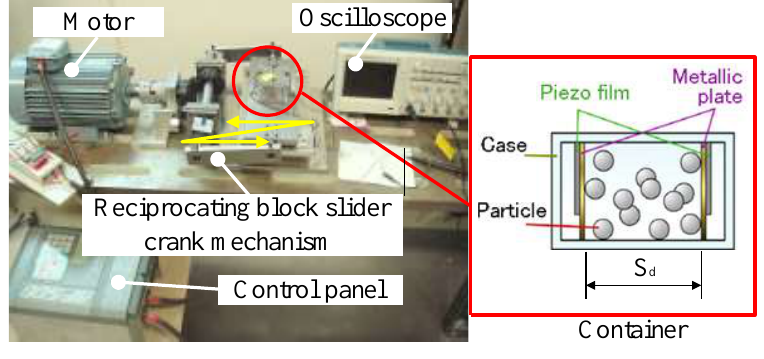
Figure 3. Experimental